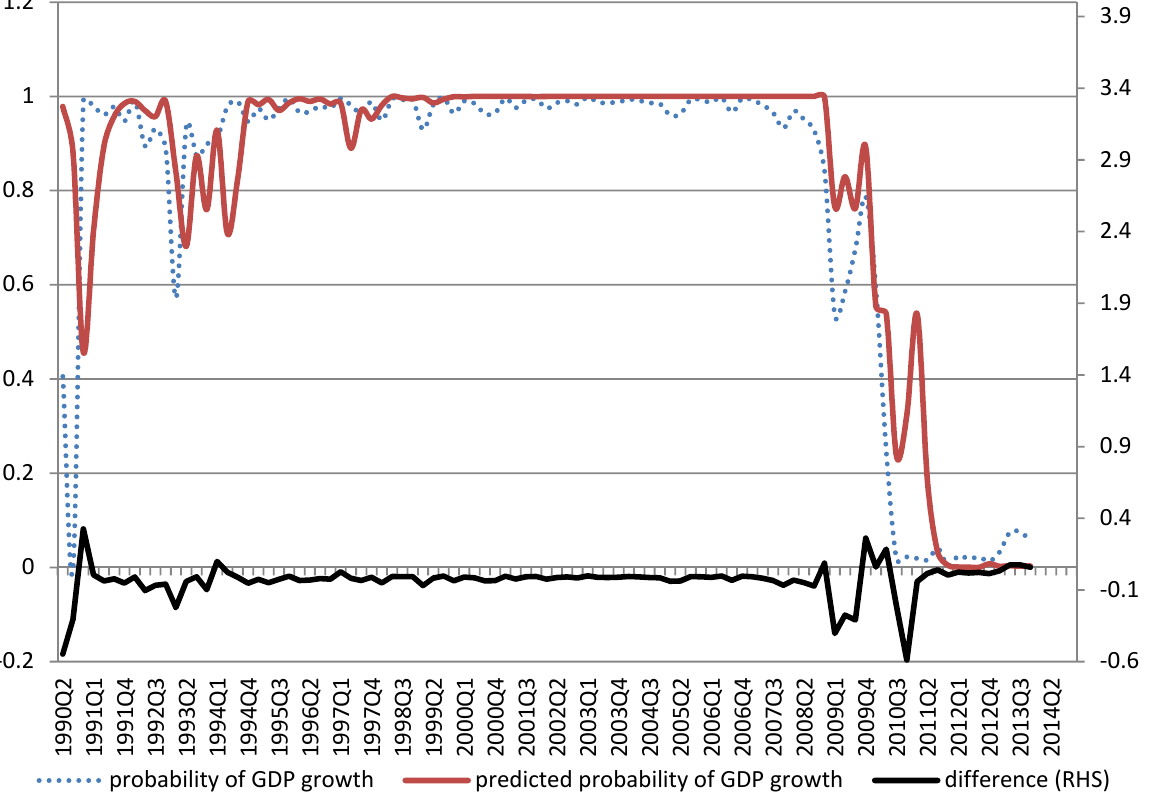
= 1 ) along with its forecast. The (cid:2930)